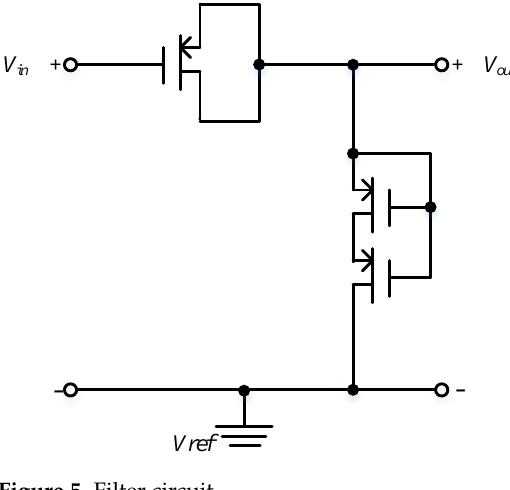
Figure 5. Filter circuit. Figure 5. Filter